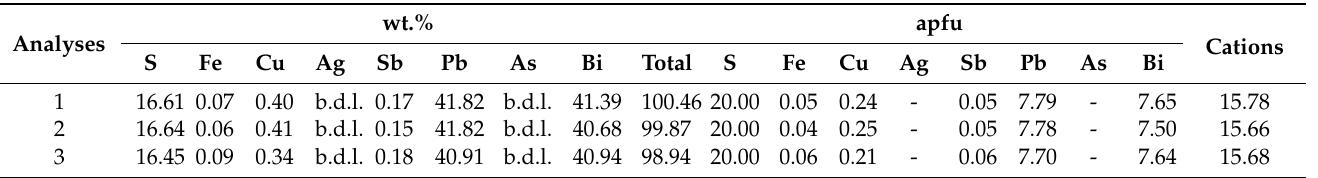
Table 9. Representative EPMA data for cosalite from the Kizhnica hornfels. The empirical formula was calculated based on 20 anions. wt.% Analyses